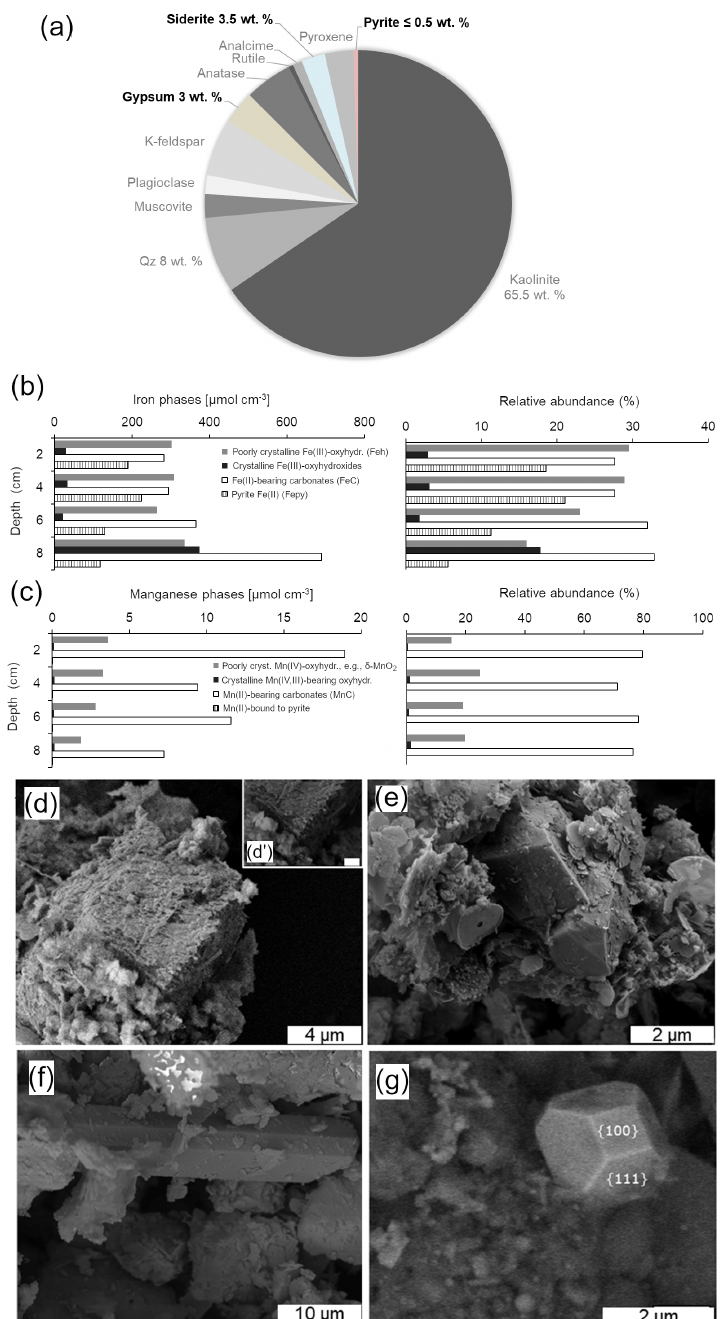
Figure 6. Representative semi-quantitative mineralogical analysis of the upper sediment (0 to 8cm depth): the XRD data (a) show that the sediments are dominated by aluminosilicates and contain gypsum, siderite and pyrite. Results from sequential extraction of iron (b) and manganese (c) portray changes in partitioning of these metals in reactive oxyhydroxide, carbonate and sulfide solid phases with increasing sediment depth. SEM-EDS analyses of rhombohedral siderite in the (d) 0–4 and (e) 4–8cm sediment depth intervals. This carbonate mineral displayed corroded surfaces near the SWI. The textures of microcrystalline equant gypsum (f) and truncated octahedral microcrystalline pyrite (g) are also shown (see text for